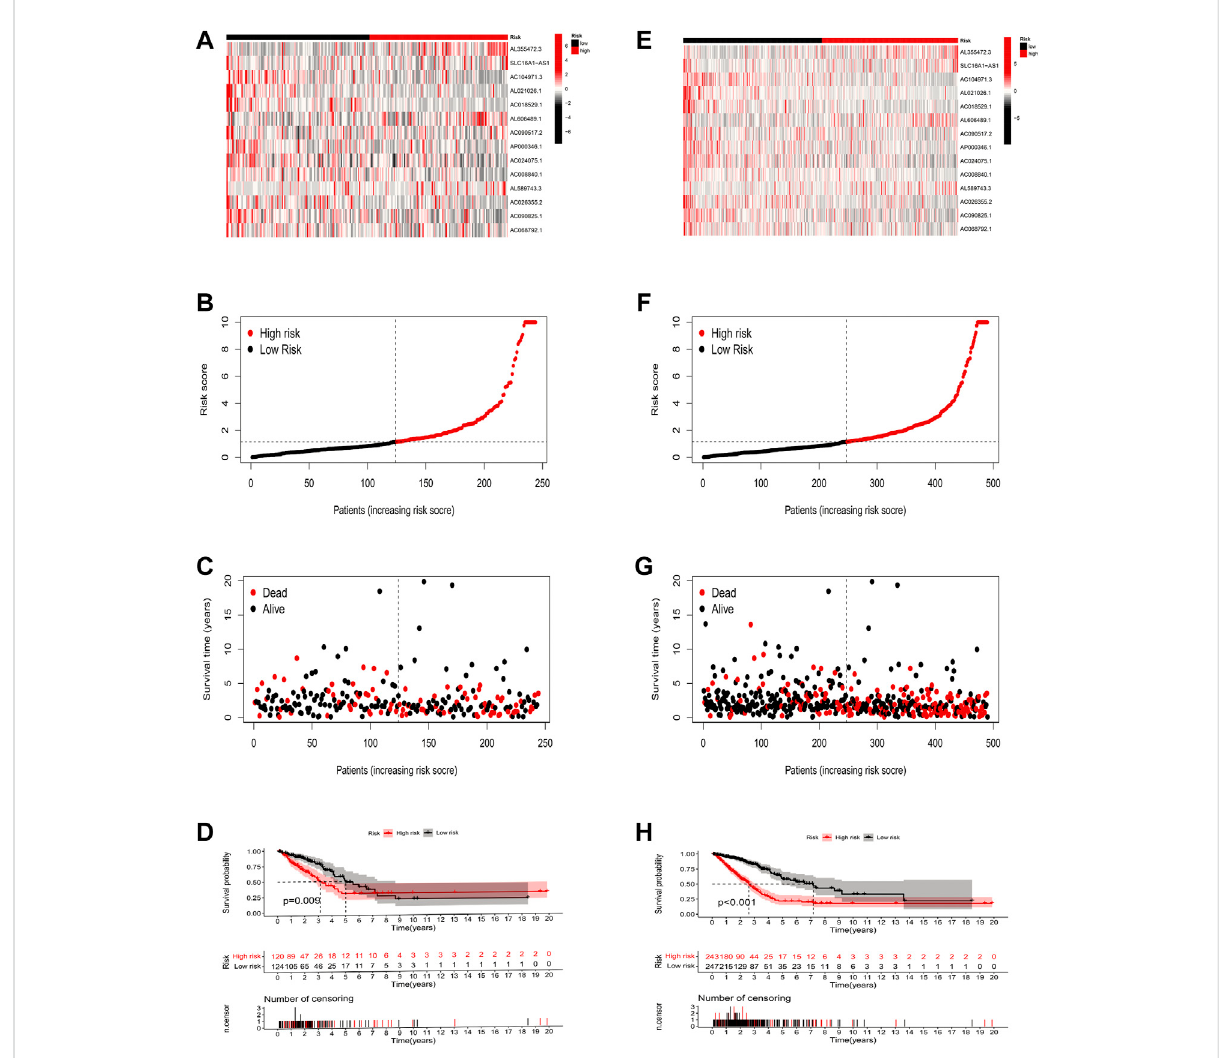
FIGURE 4 Risk model construction and validation in testing and entire sets. (A – D) The expression of 14 key prognostic lncRNAs in the testing set, the survivalstatusofLUADpatients, theriskscore,andtheresultsofK-Manalysisofsurvivalanalysis. (E – H) Theexpressionof14keyprognosticlncRNAs in the entire set, the survival status of LUAD patients, the risk score, and the results of K-M analysis of survival